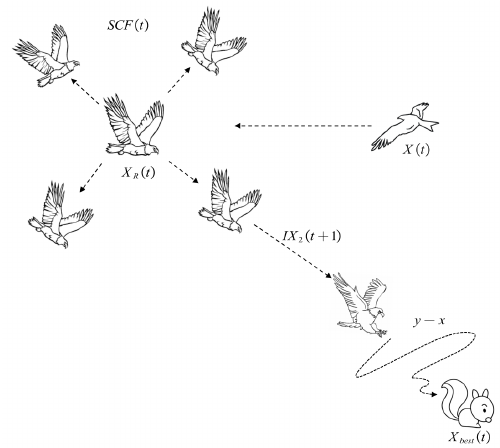
Figure 1. Aquila search around prey and attack.